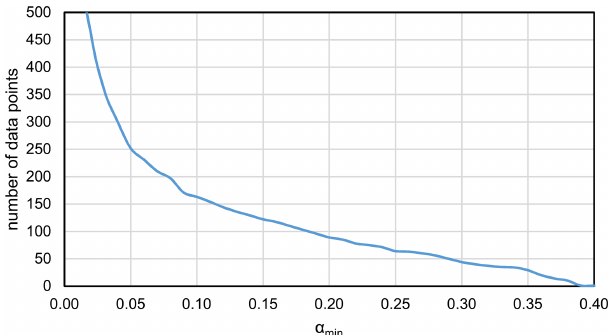
Figure 5. The number of hourly data points when the integral of the footprint function over the village area ( α ) was greater than or equal to the value indicated on the x axis. At x = 0, the total number of data points is included (4277 – outside axis